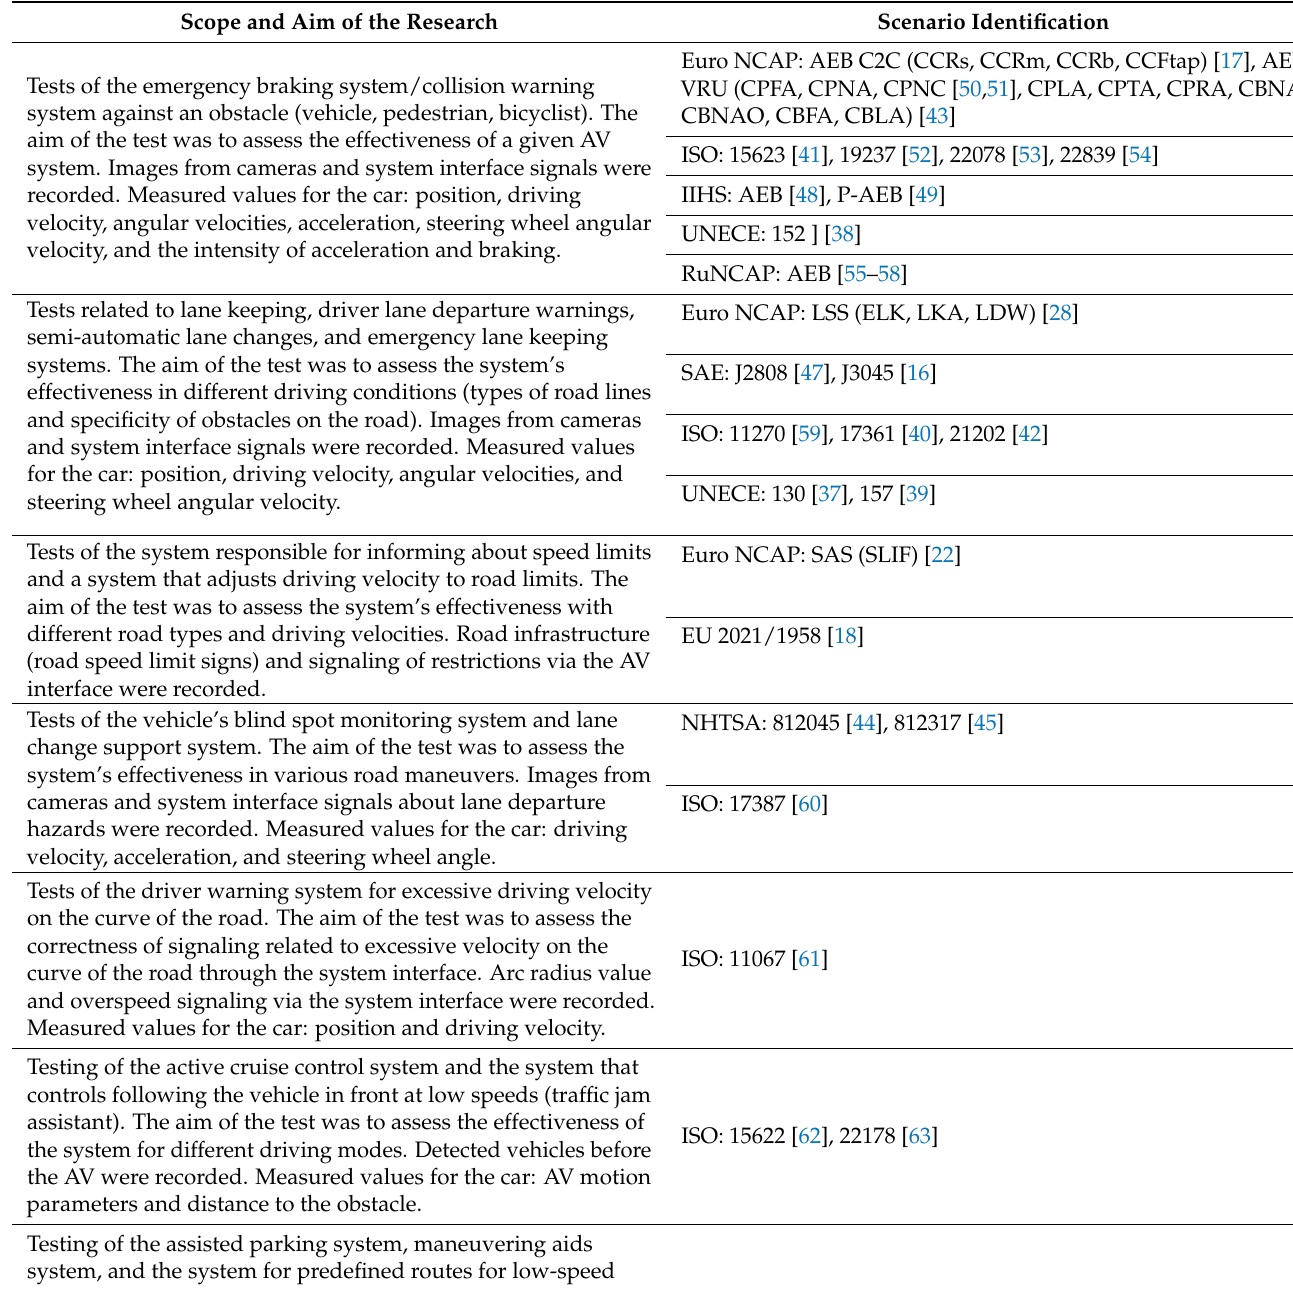
Table 4. Normative test scenarios for active safety and control systems in